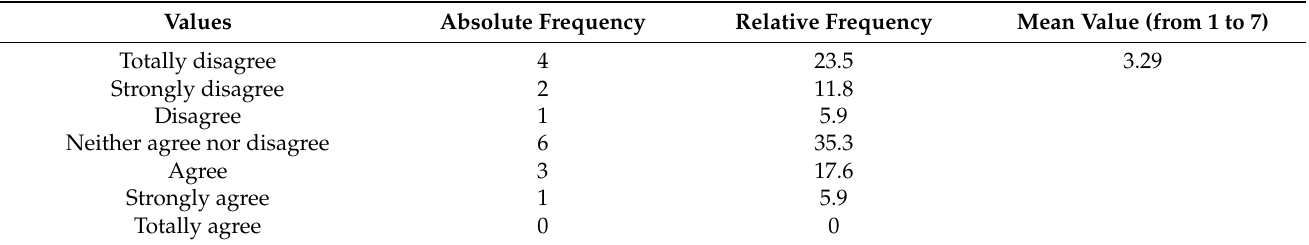
Table 1. Analysis of the results for item 1: “As an institution, the university is a masculinized space”. Values